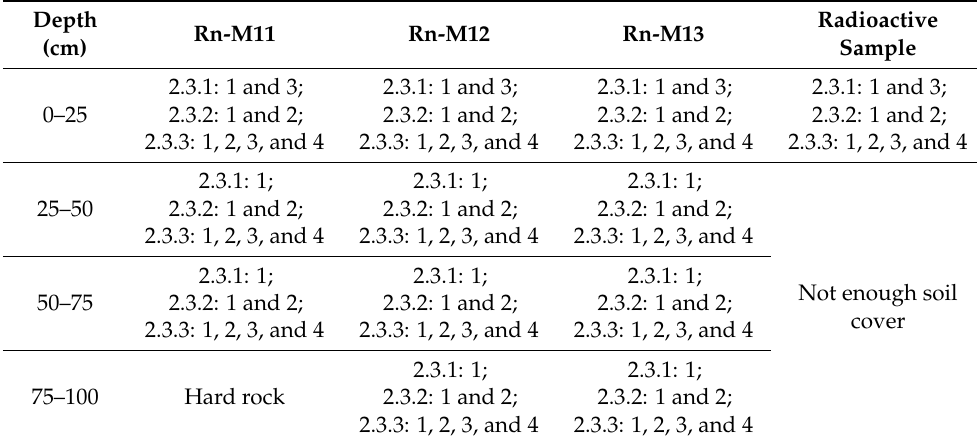
Table 1. Summary of methods used and samples for statistical